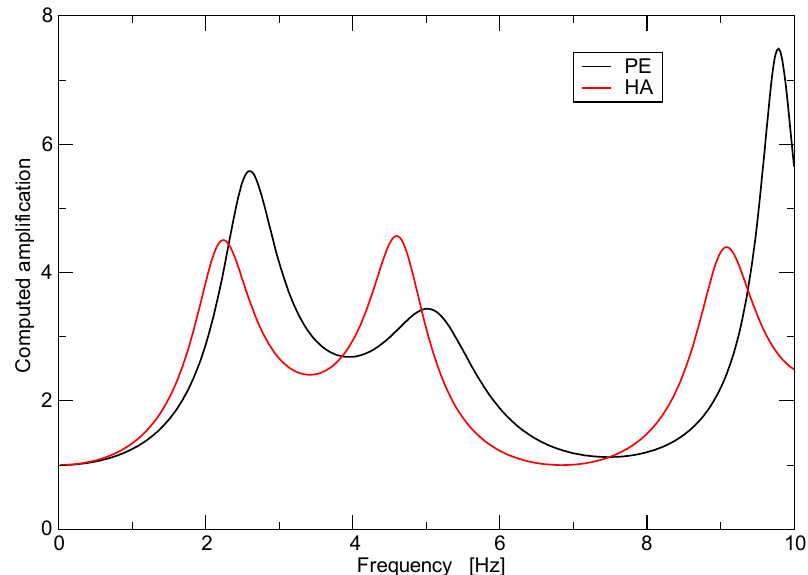
Figure 15. Panels on the left: Two examples of correlation coefficients computed from average cross- correlation of vertical component ambient noise records obtained using the linear array deployed at PE (Figure 2). Each frame shows the average values for two stations. The distance between them is indicated. Fitting a Bessel function of first kind and zero order to these curves allows us to estimate the phase velocity dispersion curve of Rayleigh waves at the site. Right panel: Final observed dispersion curve at PE (solid black line) together with the dispersion curves inverted using [37]. Each computed dispersion curve is color coded to the misfit shown at the bottom. The thick solid in the upper left corner indicates wavelengths equal to 15 times 320 m. The thick dashed line in the bottom right corner indicates wavelengths equal to 2 times 5 m.